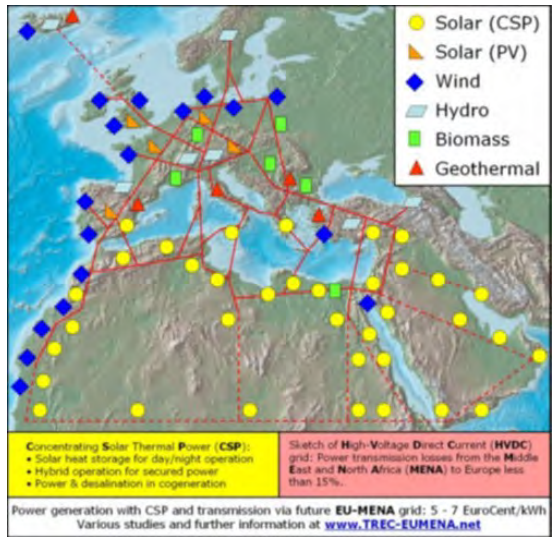
Figure 13. (Meisen & Hunter,